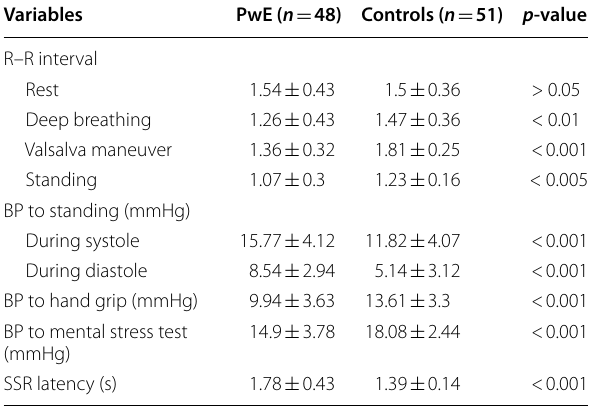
Table 2 Autonomic function tests in PwE versus controls Variables